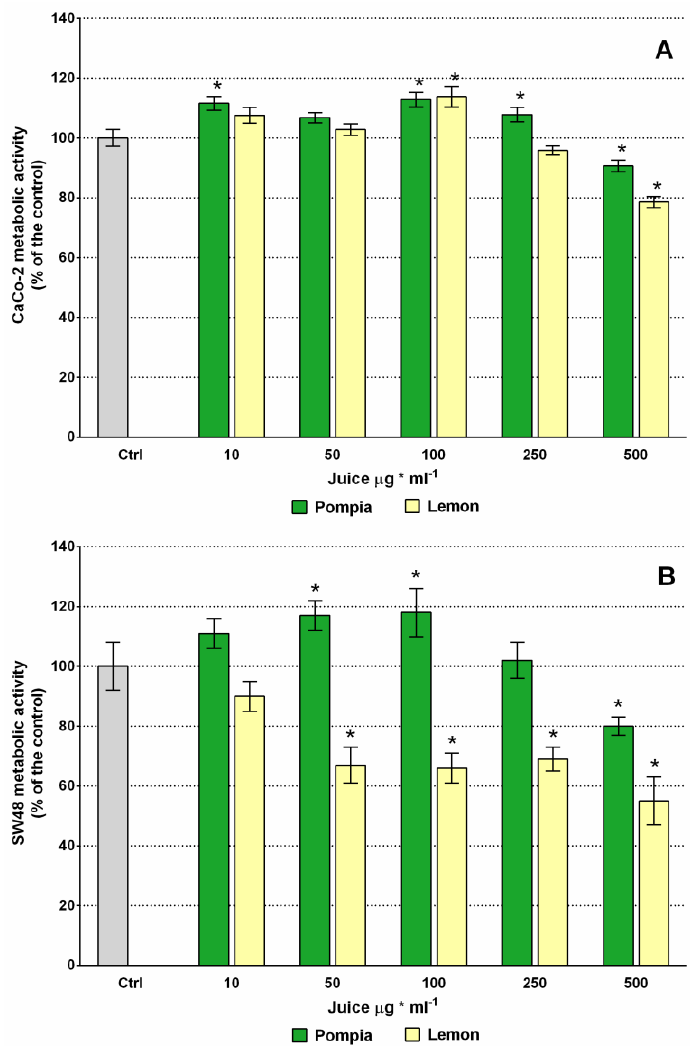
Figure 3. E ff ect of Pompia and lemon juices on metabolic activity of parental undi ff erentiated CaCo-2 Figure 3. Effect of Pompia and lemon juices on metabolic activity of parental undifferentiated CaCo- ( A ) and SW48 ( B ) colon cancer cell lines. * = p ≤ 0.01 vs 2 ( A ) and SW48 ( B ) colon cancer cell lines. * = p ≤ 0.01 vs control